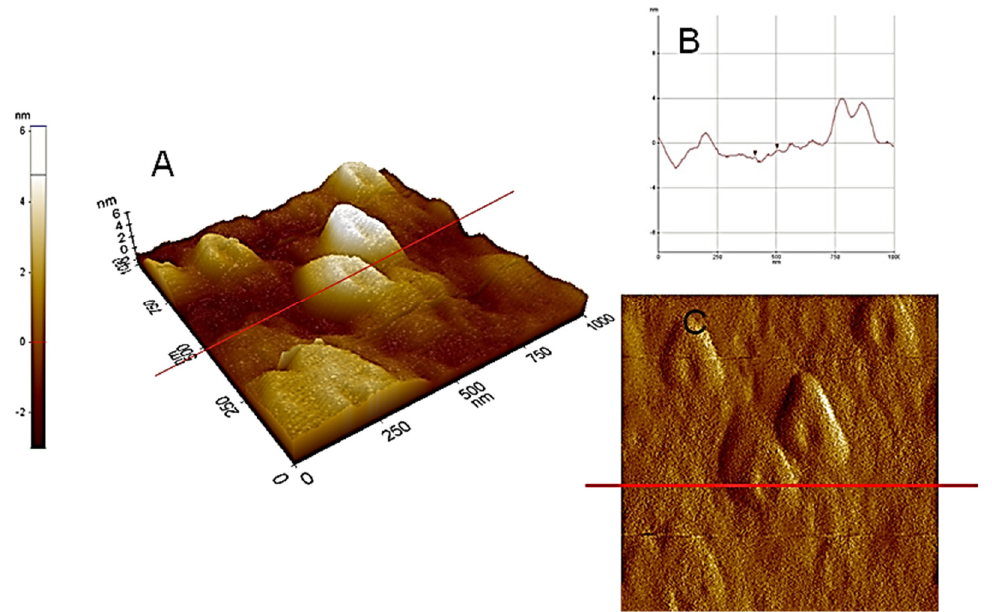
Figure 4. AFM−C (contact mode): ( A ) microtopography with 3D images of HA dispersed in pure water at pH 5, adsorbed and dried on a mica surface with section analysis ( B ) and amplitude ( C ).